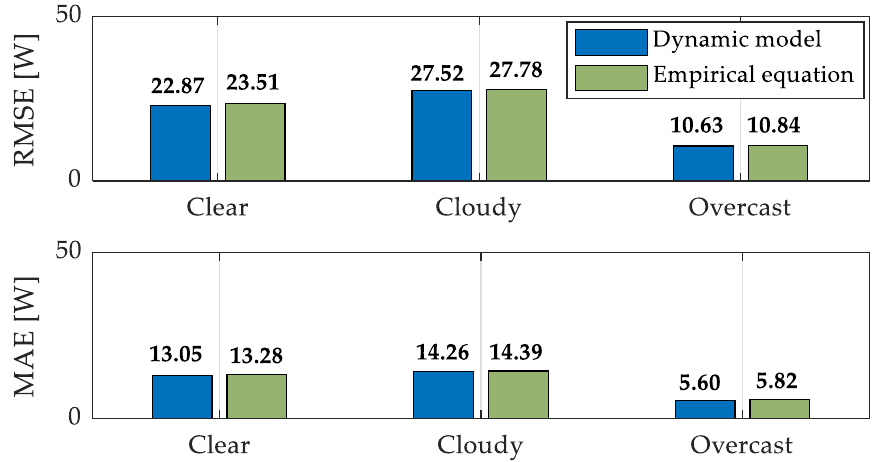
Figure 9. Comparison of the static and dynamic electric model for RMSE and MAE under different weather conditions.